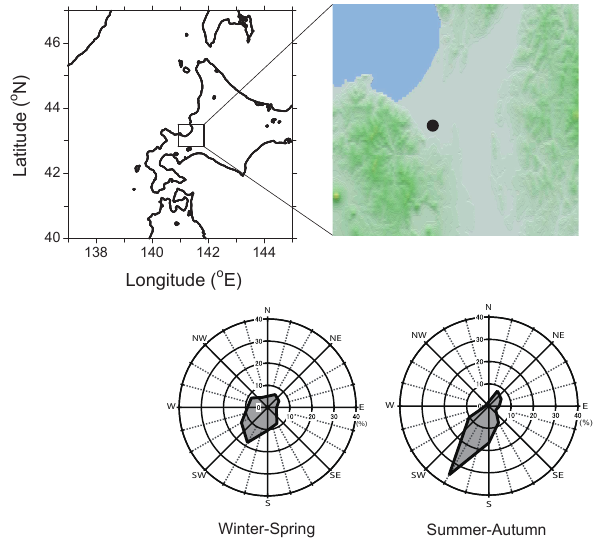
Fig. 1. Location of the sampling site (the Sapporo forest meteo- rology research site). Also shown is the observed frequency of lo-